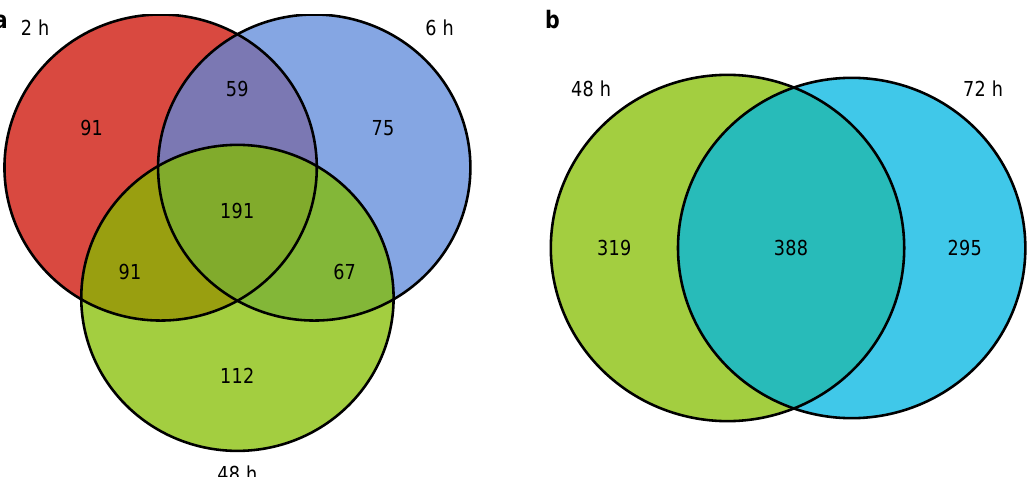
Figure 5. Venn diagrams displaying the overlap in features with VIP scores > 1 in PLS-DA models discriminating ( a ) between the polar metabolome, as measured by polar negative assay, of microtissues exposed to low-dose sunitinib and control microtissues at 2, 6 and 48 h after initial exposure, and ( b ) between the lipidome, as measured by lipid negative assay, of microtissues exposed to high-dose sunitinib and control microtissues at 48 and 72 h after initial exposure.